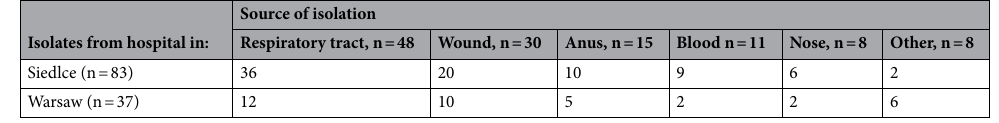
Table 5. MRSA isolation